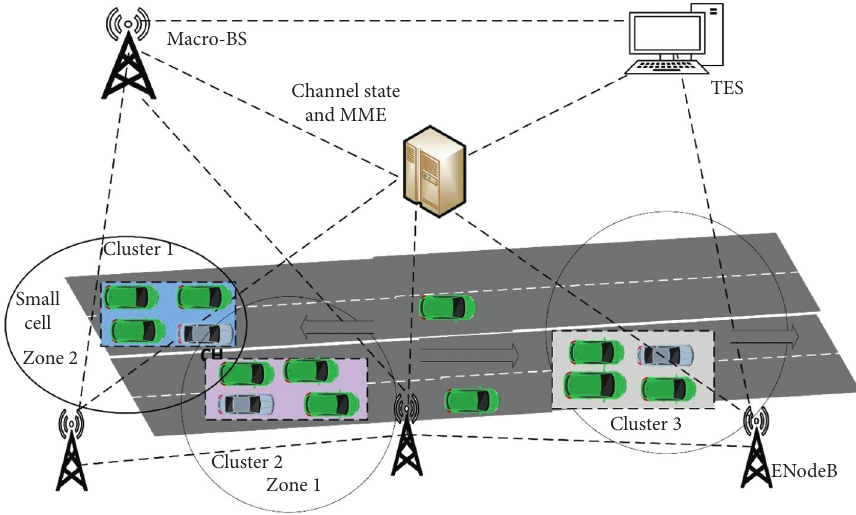
Figure 1: Proposed architecture for resource allocation in CDS. Table 1: Symbols used in proposed design and